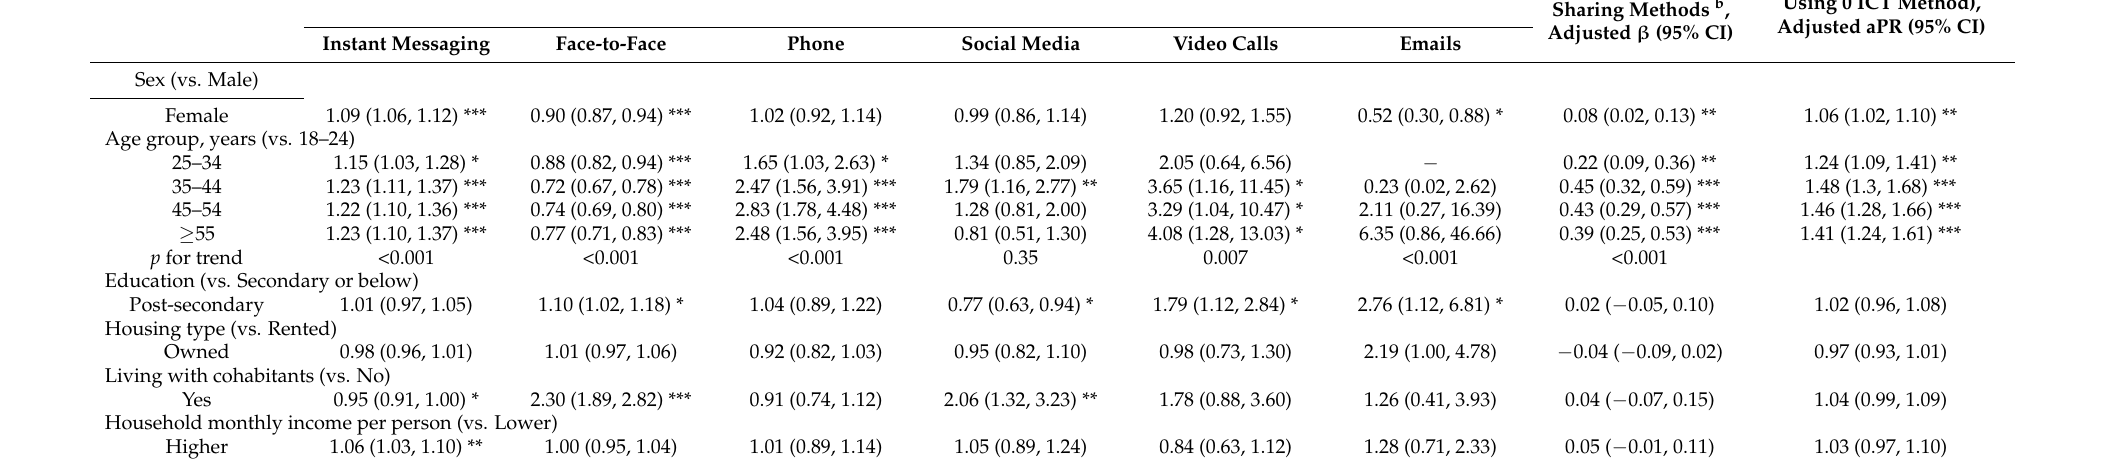
Table 2. Associations of sociodemographic characteristics with COVID-19 information sharing methods a ( n =